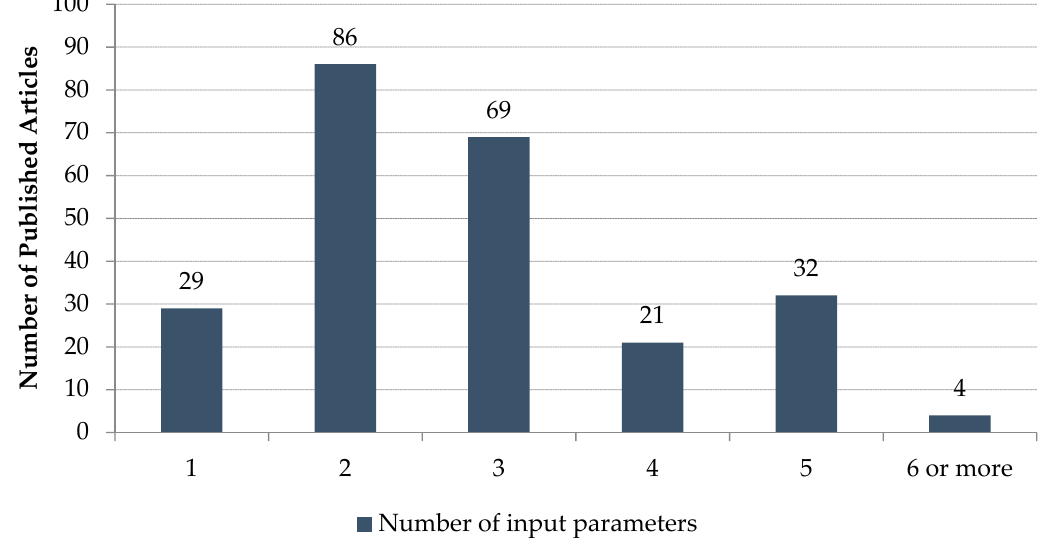
Figure 6. Distribution of articles according to the number of input parameters for price forecasting (in the observed sample of articles).